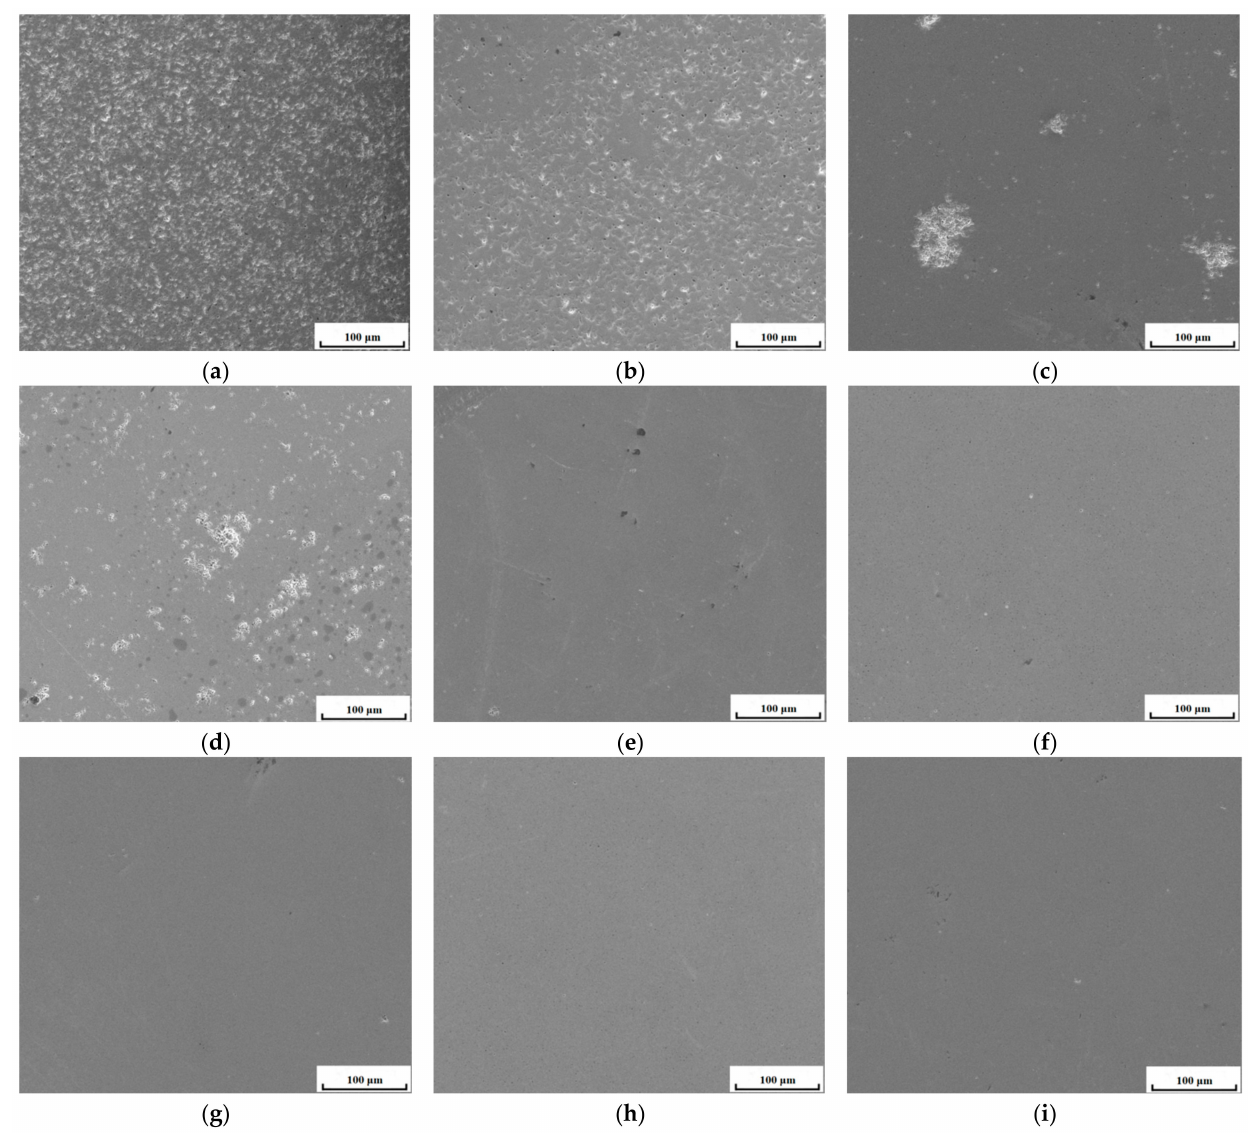
Figure 2. The Gd 2 O 3 bulk’s microstructure, sintered at 1400 ◦ C for 6 h ( a ), 12 h ( b ), and 24 h ( c ); the Gd 2 O 3 bulk’s microstructure, sintered at 1500 ◦ C for 6 h ( d ), 12 h ( e ), and 24 h ( f ); the Gd 2 O 3 bulk’s microstructure, sintered at 1600 ◦ C for 6 h ( g ), 12 h ( h ), and 24 h ( i ).